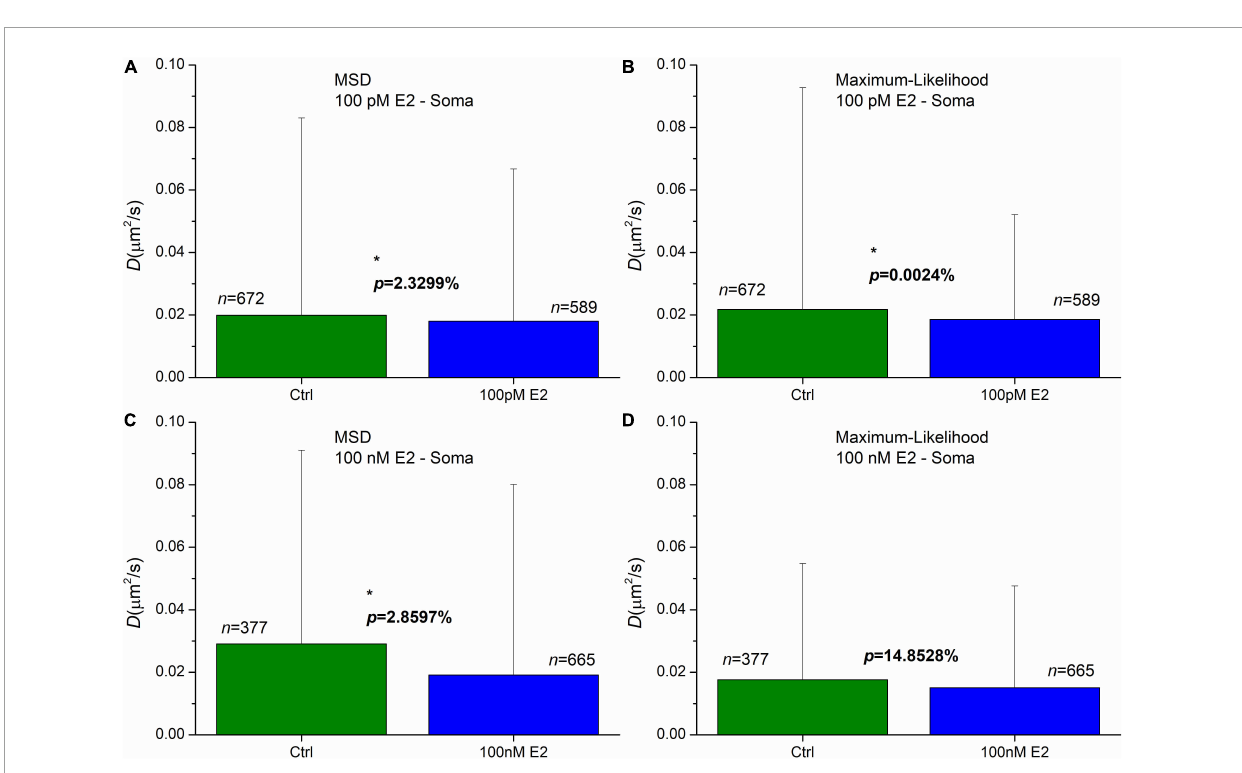
FIGURE5 The effect of E2 treatment on the diffusion coefficient of GluR2-AMPAR molecules in the soma’s plasma membranes of dPC12, live-cell. The E2 treatments were carried out by the concentration of 100 pM (A,B) and 100 nM (C,D) . Both the mean square displacement (MSD) (A,C) and the maximum likelihood-based estimation (MLE) (B,D) methods were used for further analysis to obtain the diffusion coefficients from the recorded trajectories. The graphs represent the groups as mean and SD values. The probability values of significant differences calculated by Kolmogorov–Smirnov test (* p < 0.05) and the number of trajectories in each group are also shown.